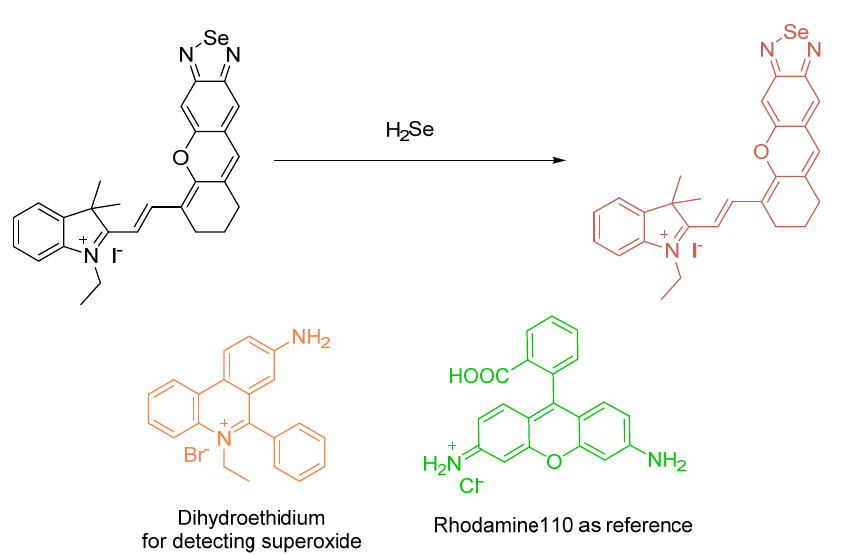
Figure 59. Structure of NIR–H 2 Se synthesized by Gao et al. and its reaction with H 2 Se. Structure of dihydroethidium and rhodamine 110 are also depicted.